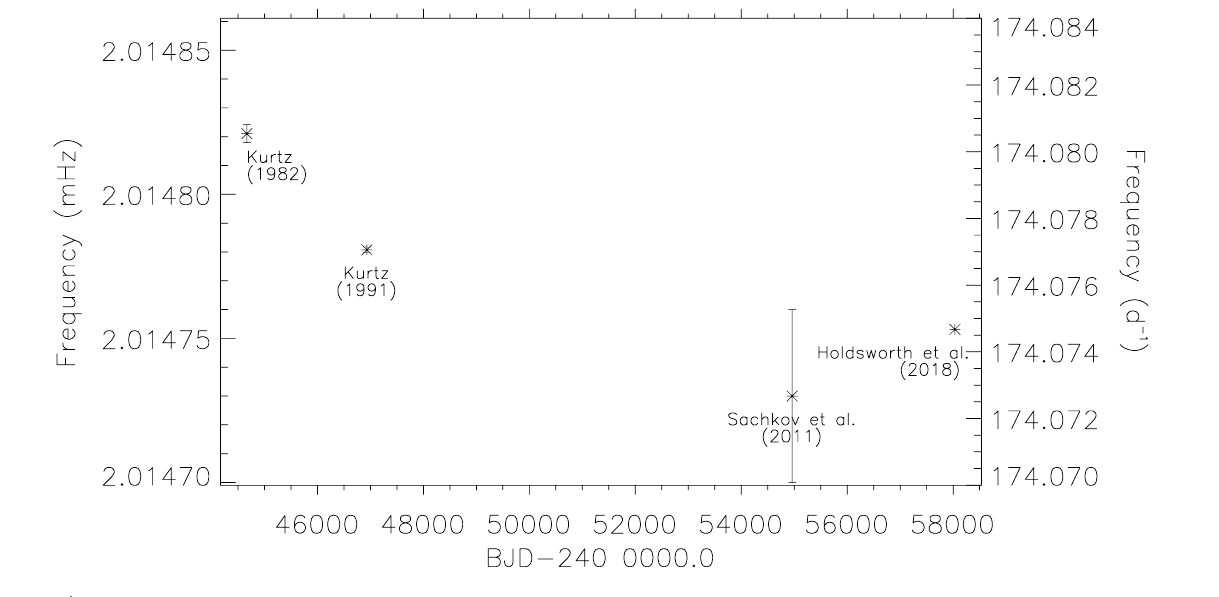
Frontiers in Astronomy and Space Sciences |